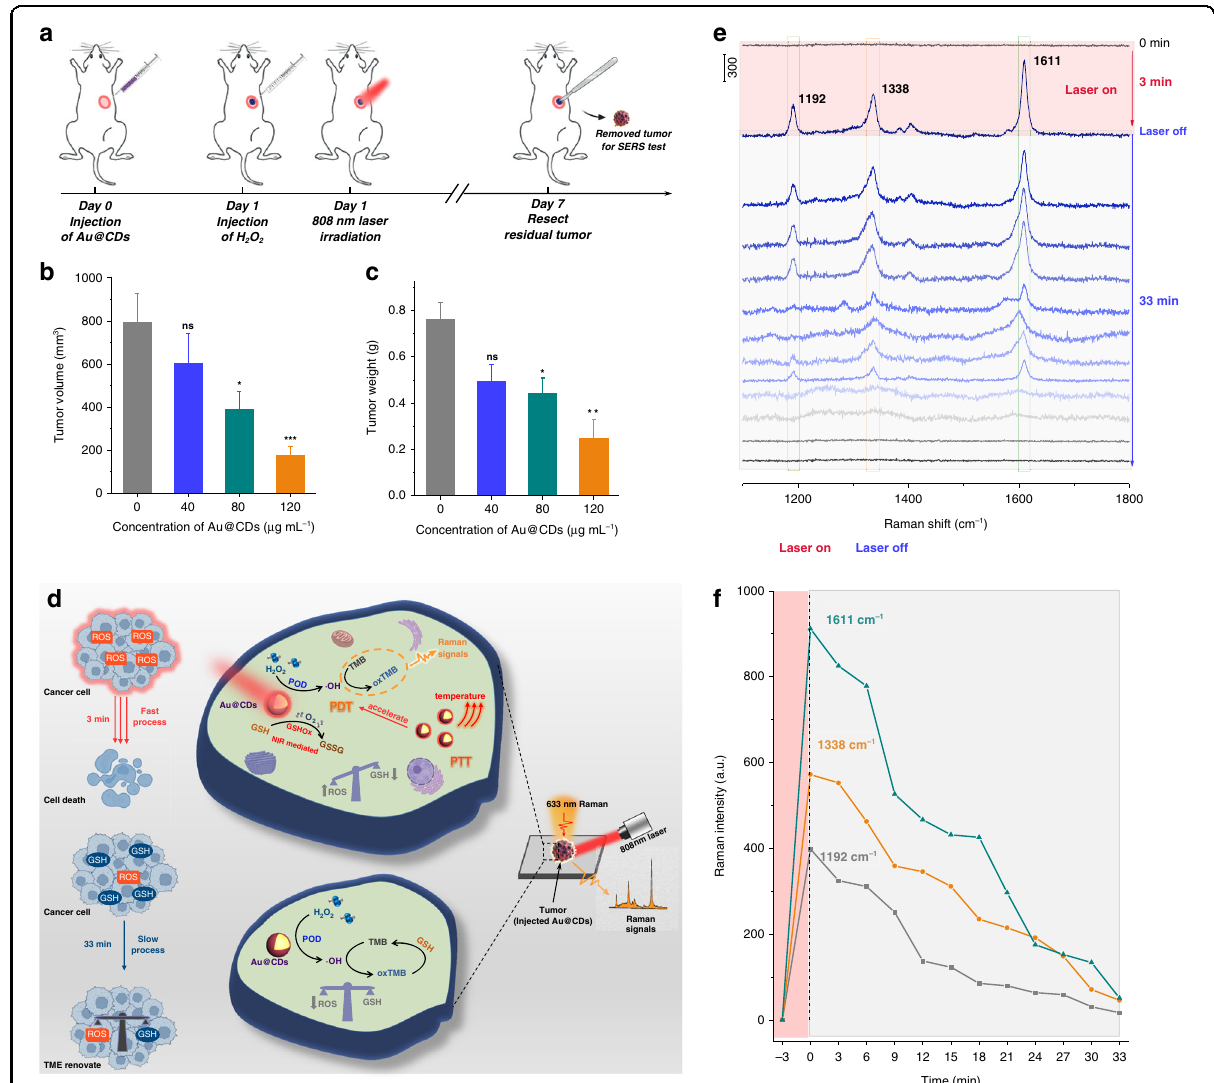
Fig. 5 Therapeutic effect of Au@CDs and SERS monitoring of the catalytic reaction in the TME. a Treatment schedule for in vivo anti-metastasis study. b Tumor volume and c tumor weight in mice after Au@CDs + H 2 O 2 + 808 nm laser treatments (2 W cm − 2 ) with different concentration of Au@CDs. d Illustration of Raman studies of intratumor oxidative stress processes. e Time-dependent SERS spectra during the process of oxidative stress in tumor and f time-dependent intensities of the characteristic bands of